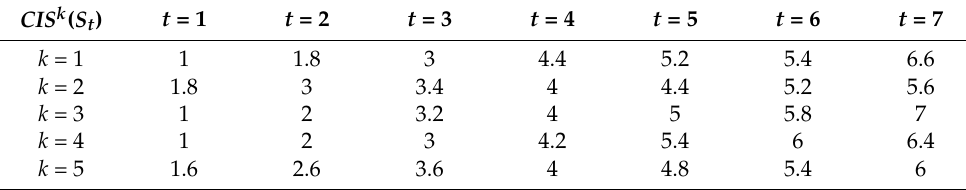
Table 6. The CIS numerical scales for different DM k